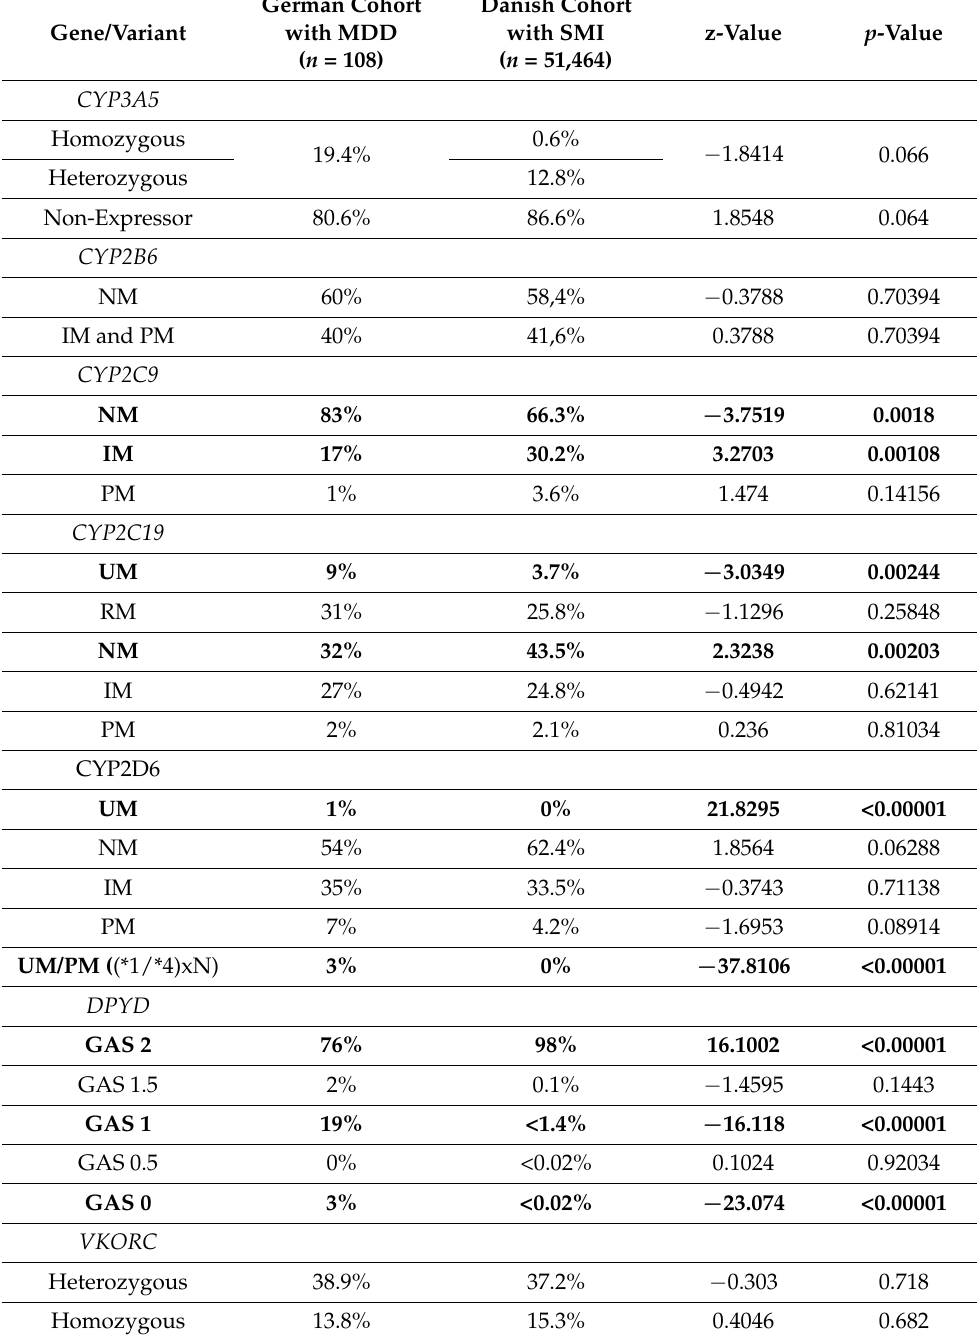
Table 2. Frequencies of a German MDD cohort in comparison to a large Danish cohort with SMD, the z-values and p -values of the analysis. Statistically significant differences are highlighted. GAS = gene activity score; NM = normal metabolizer, IM = intermediate metabolizer, RM = rapid metabolizer, PM = poor metabolizer, UM = ultra-rapid